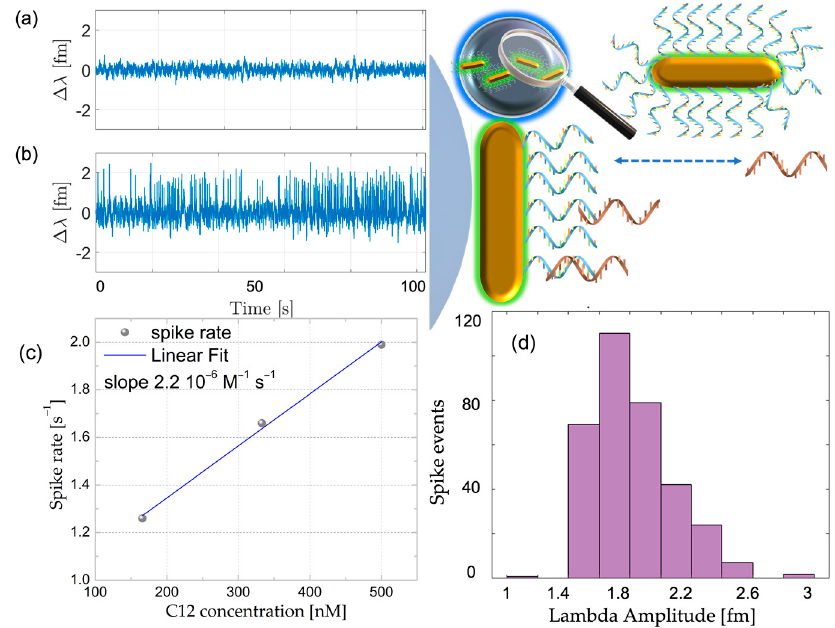
Figure 9. ( a ) Background WGM shift signal for ∆ λ after 12 h in H 2 O, ( b ) spike signals after adding 166 nM of C12, ( c ) spike rate dependence with C12 full complementary increasing concentration. ( d ) Histograms of the waiting times for events extracted from WGM ∆ λ shift signal displayed in ( b ) for 166 nM C12.